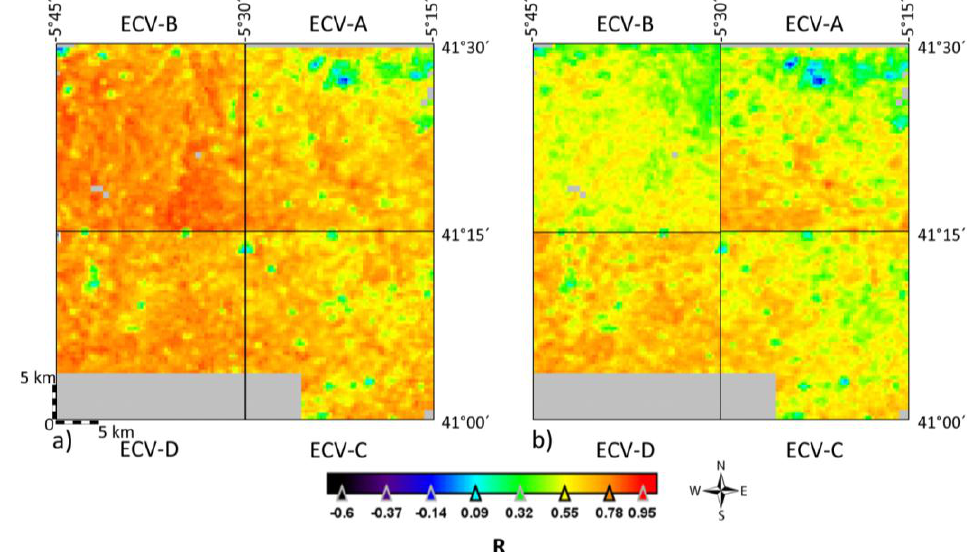
Figure 5. Coefficient of variation (CV) of the ASAR SM mean, evaluated for each ASAR acquisition over the Spanish ECV-sized pixels, during the observation period 2005–2010. Seasonal-based values are highlighted by different colors. (Winter: DJF; Spring: MAM; Summer: JJA; Autumn: SON).